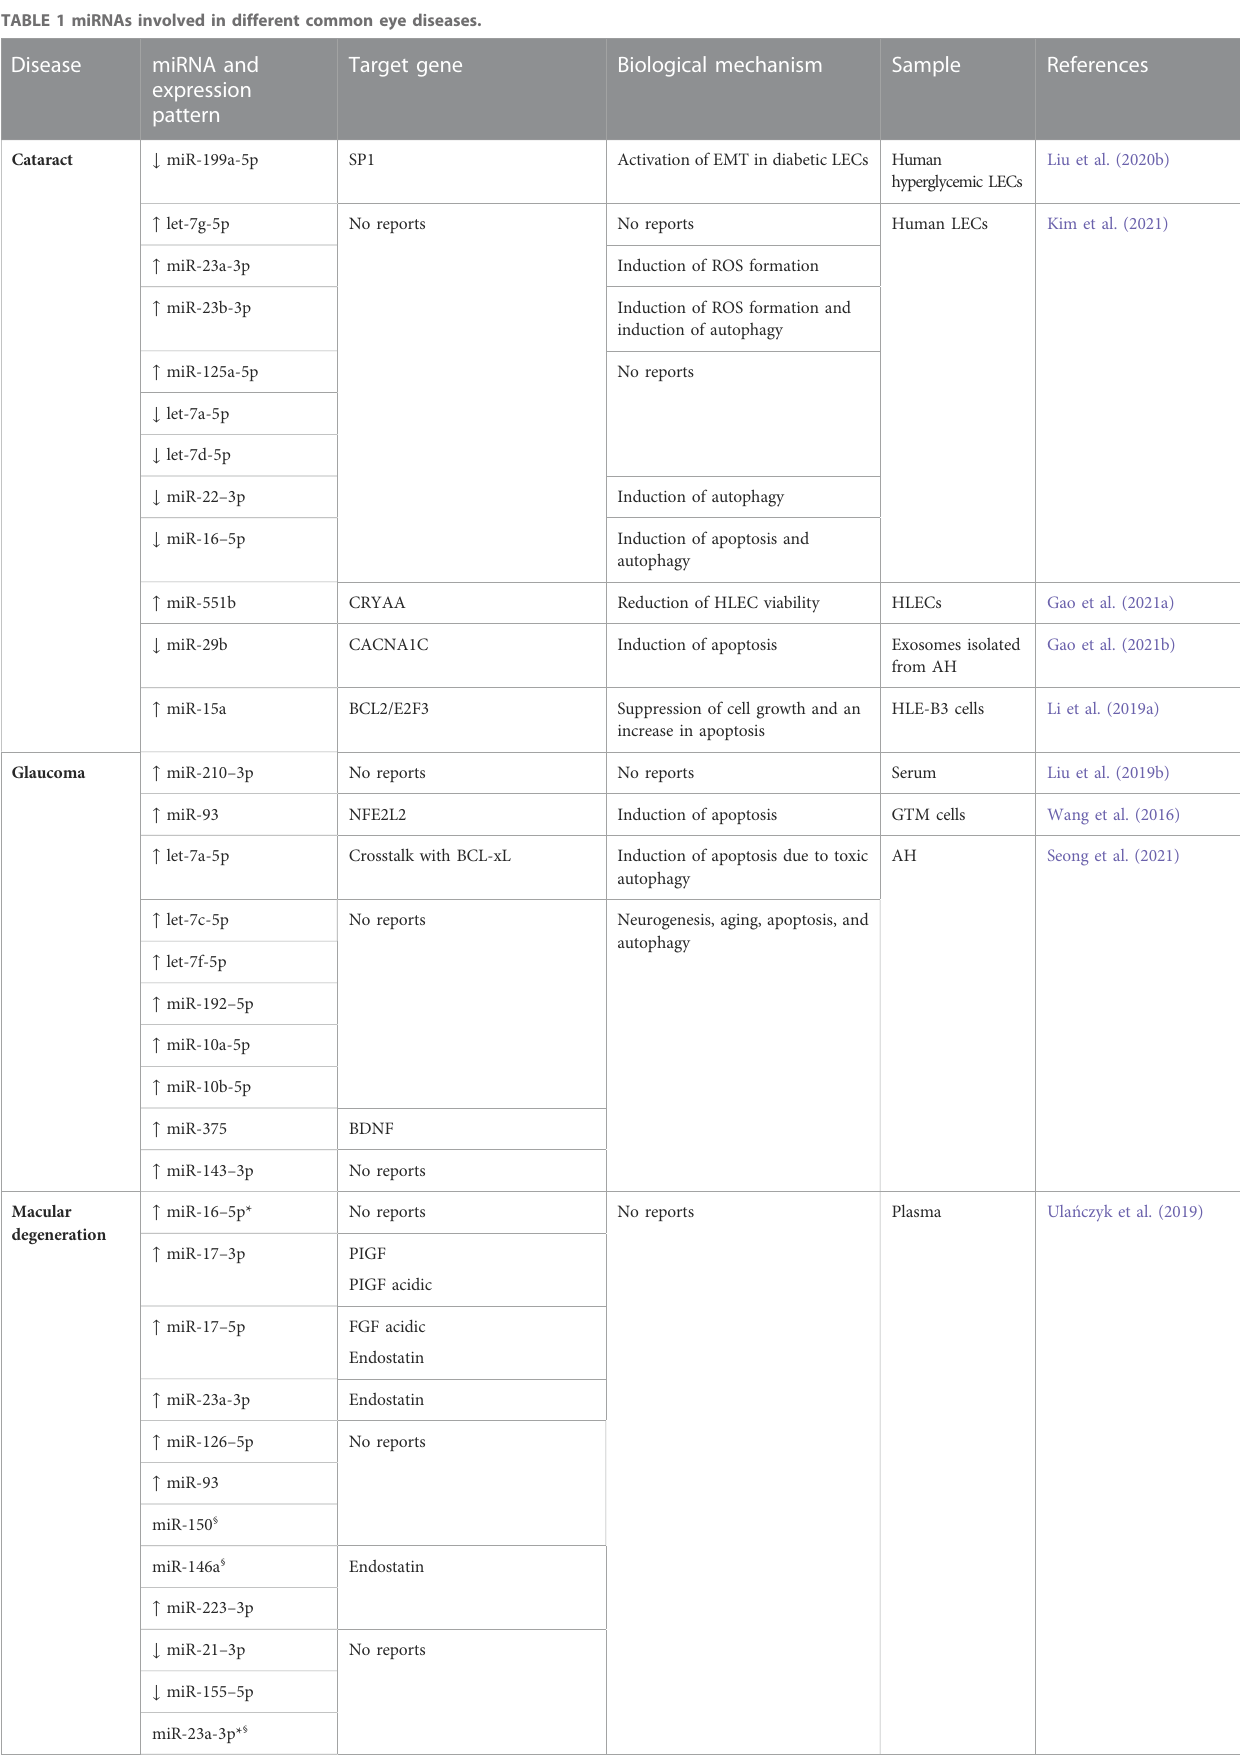
TABLE 1 miRNAs involved in different common eye diseases.